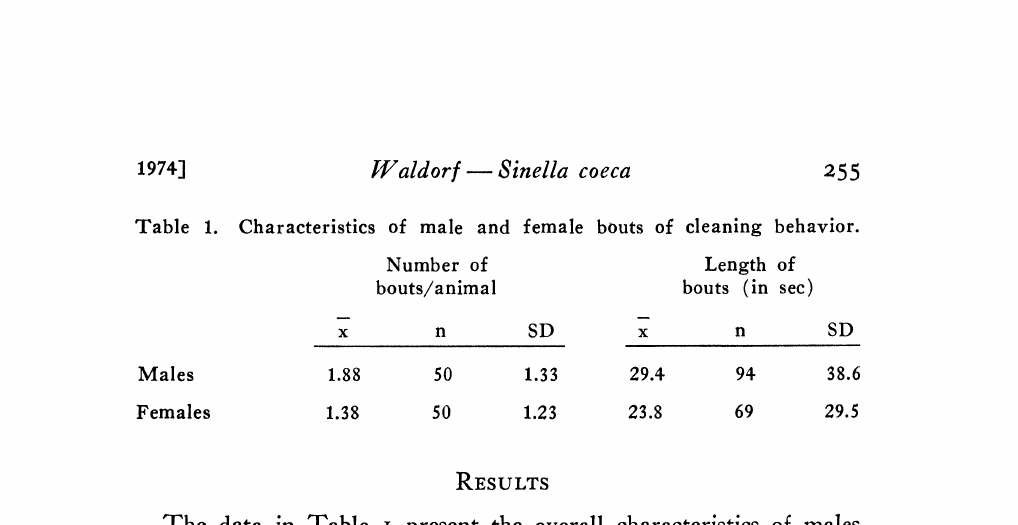
Table 1. Characteristics of male and female bouts of cleaning behavior. Number of Length of bouts/animal bouts (in see)